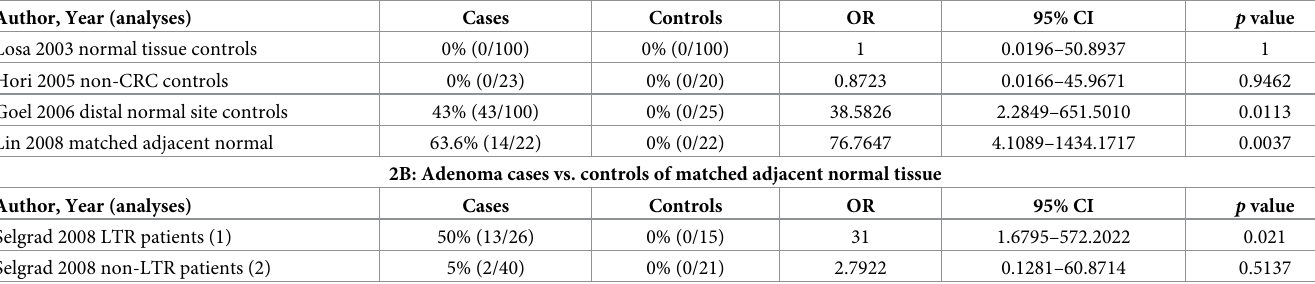
(A)JCV T-antigen protein expression in CRC patient cases vs. normal tissue (within the same patient) or non-CRC (healthy patients) controls, as specified. (B)JCV T- antigen protein expression in LTR and non-LTR adenoma patient cases vs. normal tissue (within the same patient) controls. List of abbreviations. a CI = Confidence intervals. b CRC = colorectal cancer. c LTR = Liver transplant patients d OR = Odds